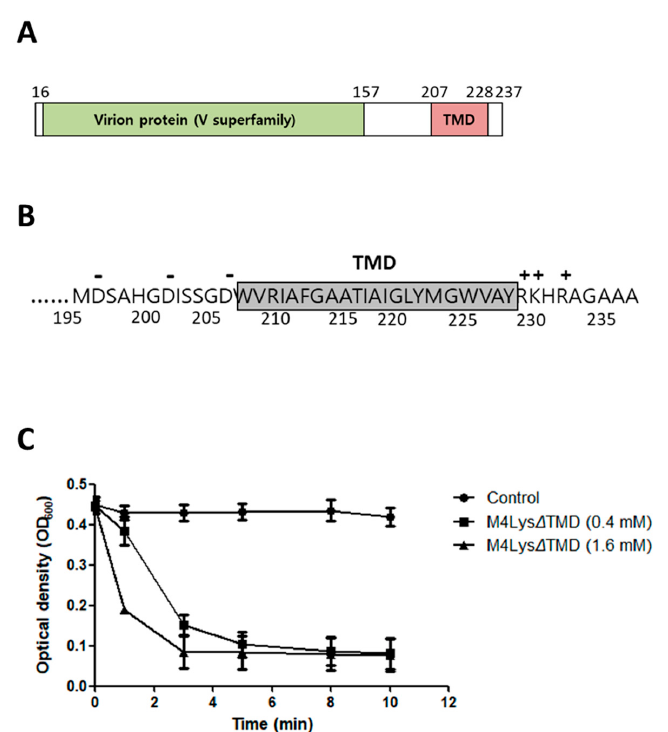
Figure 3. Domain analysis of M4Lys and its peptidoglycan degradation activity. ( A ) Domain analysis of M4Lys. The numbers represent amino acid positions; ( B ) Charge distribution of the TMD region of M4Lys. Positive and negative charges are represented as + and -, respectively, above the amino acid sequences. Numbers under the amino acid sequences indicate amino acid position; ( C ) Turbidity reduction assay of purified M4Lys ∆ TMD using E. coli peptidoglycan. Closed circles, bu ff er treatment (control); closed squares, 0.4 mM M4Lys ∆ TMD treatment; and closed triangles, 1.6 mM M4Lys ∆ TMD treatment. Turbidity reduction assays were performed in triplicate and the results of each treatment are represented by the mean ± standard deviation.